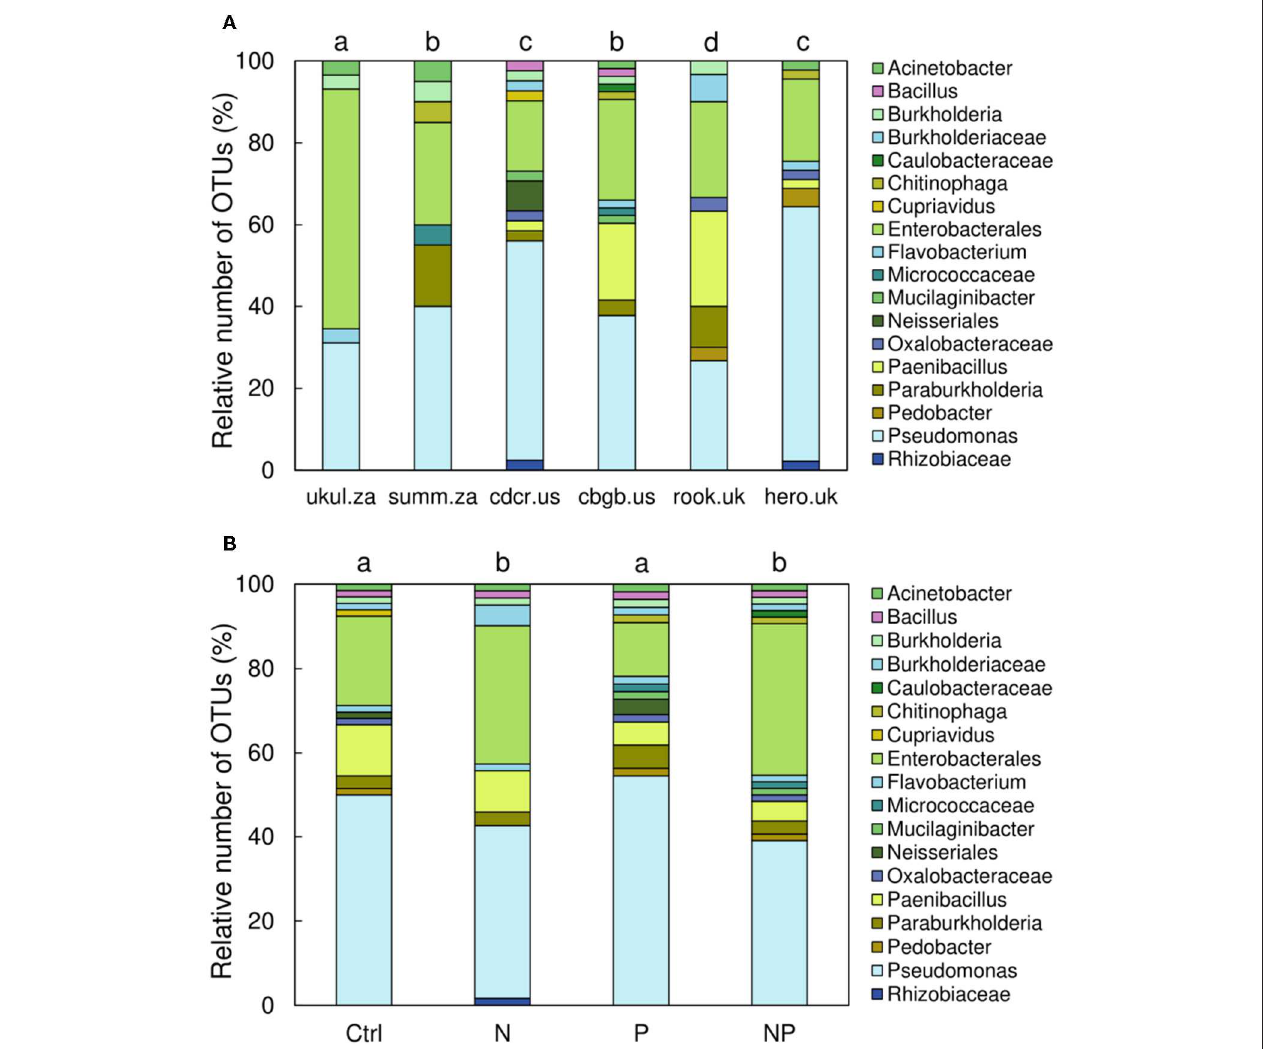
FIGURE 4 | Relative number of operational taxonomic units (OTUs) of phosphorus-solubilizing bacteria in 0–15cm soil depth sorted by (A) sites and (B) treatments. Different letters indicate significant differences ( p < 0.05) among sites (A) and among treatments (B) .